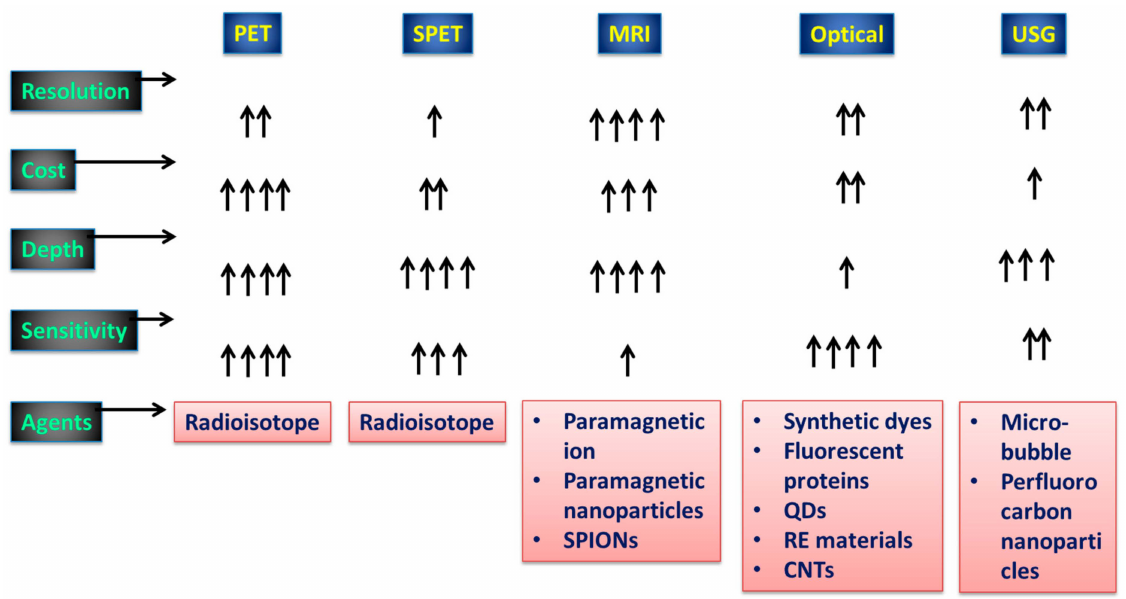
Figure 1. Aspects of diagnostic imaging systems employed in practice. The conventional diagnostic tools and their viabilities with respect to signal capturing are shown. A single arrow represents the minimum viability, and four arrows represents high